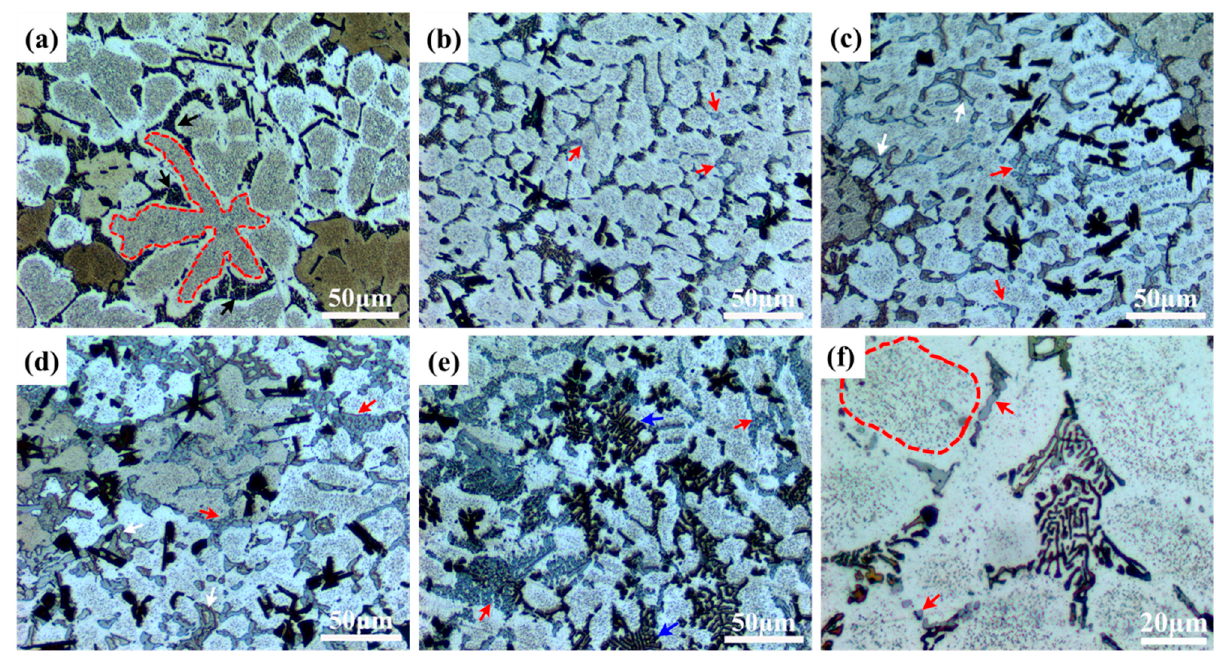
Figure 2. Optical microscope images of heat-treated alloys: ( a ) 0 Ni alloy, ( b ) 0.5 Ni alloy, ( c ) 1.0 Ni alloy, ( d ) 2.0 Ni alloy, ( e ) 4.0 Ni alloy, ( f ) magnified picture of 0.5 Ni alloy. The arrows with different colors indicate different phases.